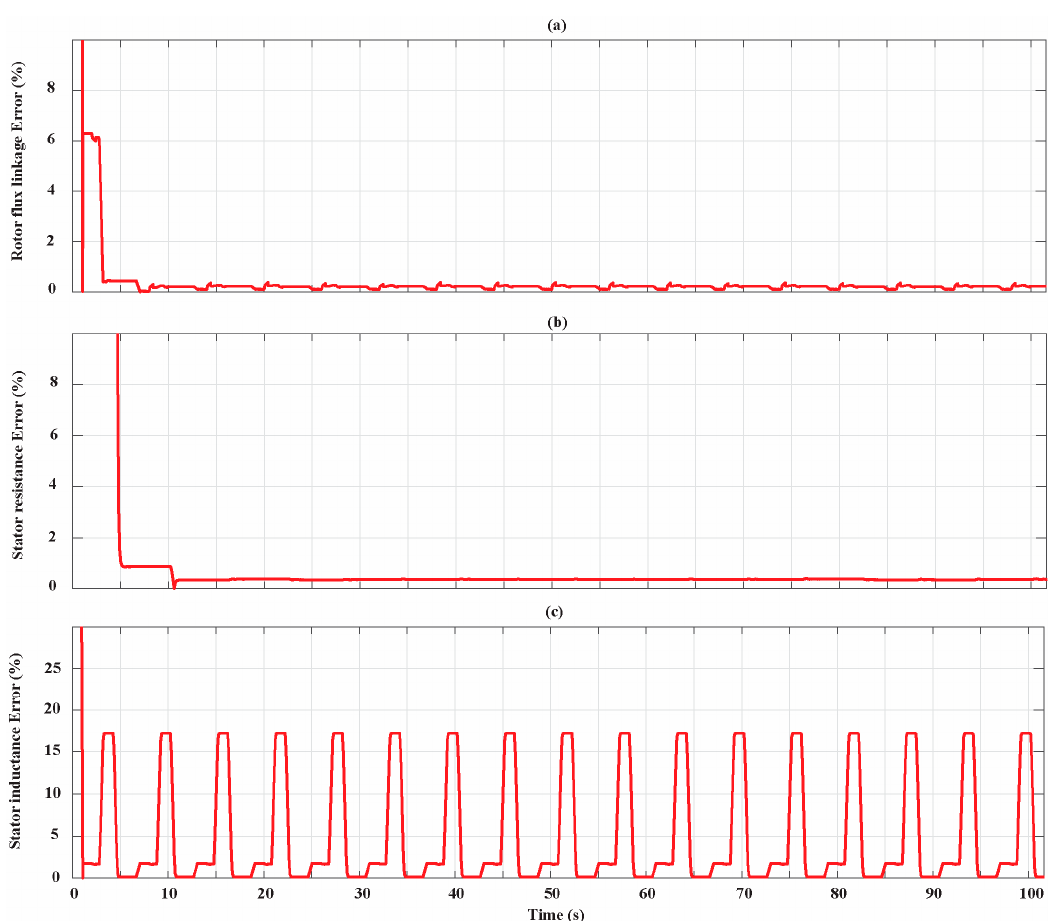
Figure 13. Percentage estimation error for the Bonfiglioli 65. ( a ) Rotor flux linkage estimation error; ( b ) stator resistance estimation error; ( c ) stator inductance estimation error. Table 3. Execution times of multiple parallel runs.